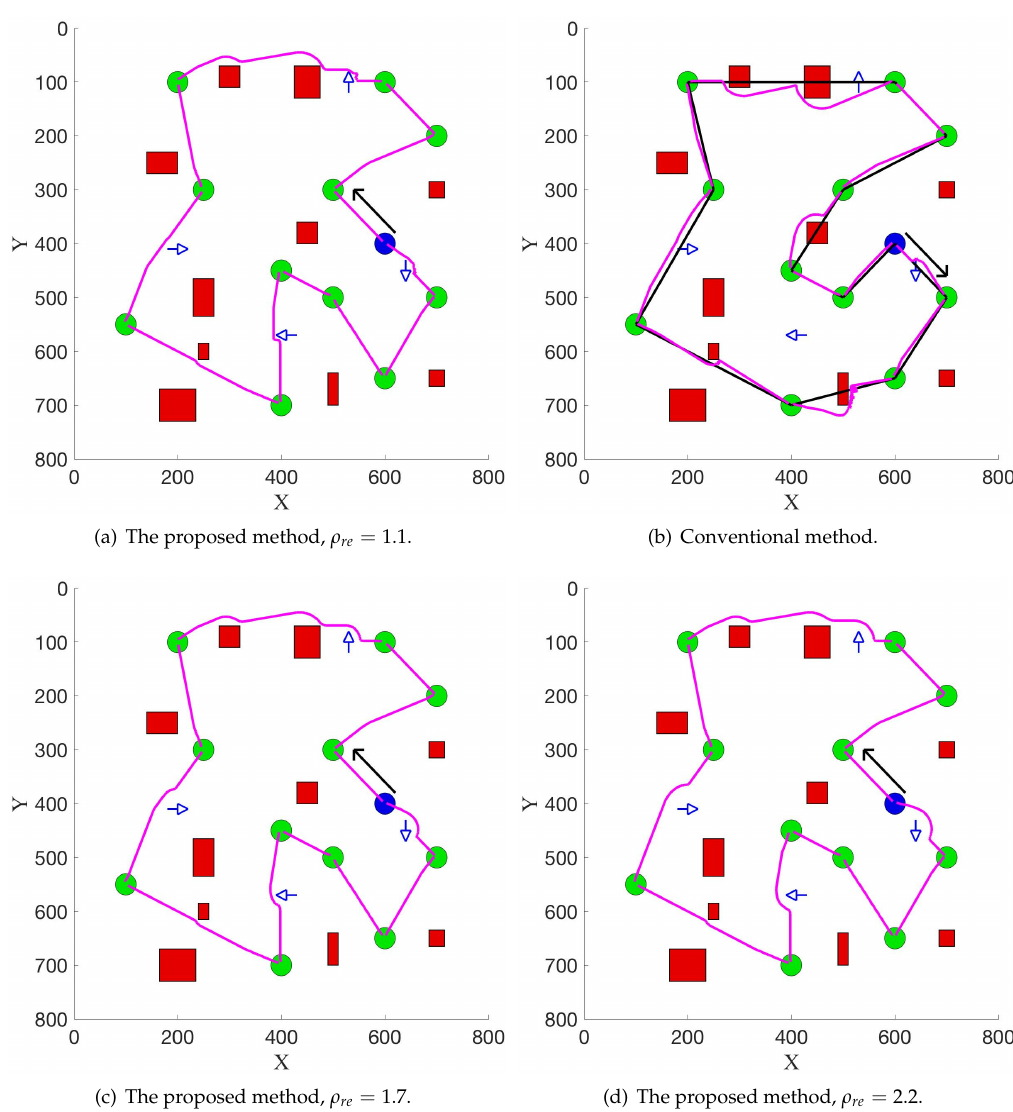
Figure 5. Experimental results in the second